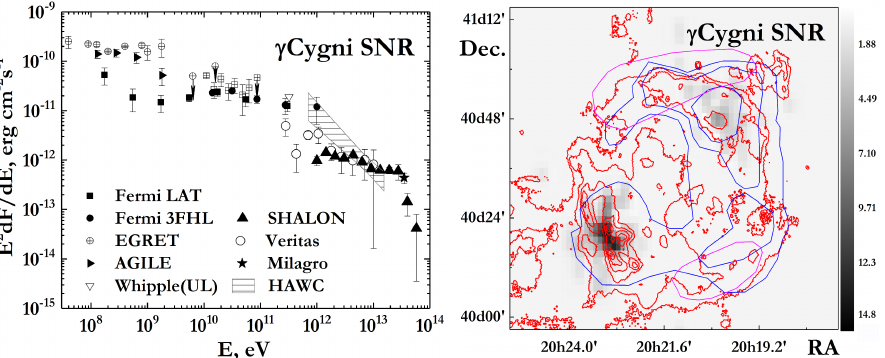
Figure 3. ( left ): Spectral energy distribution of γ Cygni SNR: (cid:78) at TeV energies show the data from SHALON observations. ( right ): Emission map of SNRs by SHALON (grey scale). Red lines show Canadian Galactic Plane Survey DRAO data; magenta lines are the X-ray data by ROSAT, and blue lines show MeV-GeV emission regions by Fermi LAT (see text for the